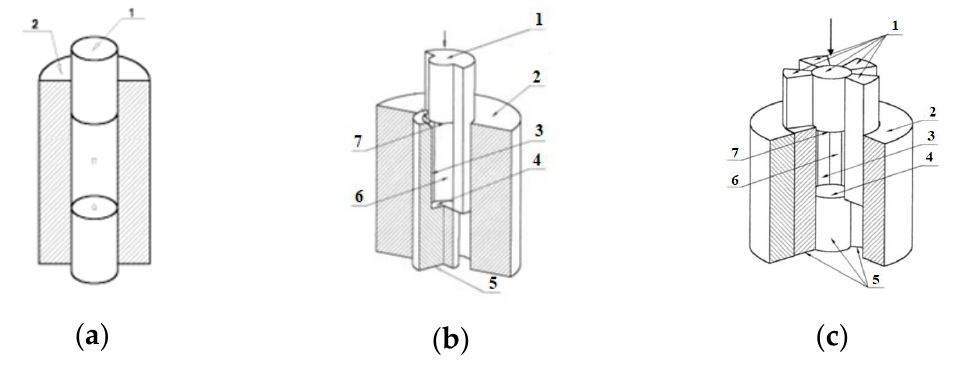
Figure 1. Cylindrical molds for dry pressing: ( a )—standard mold (1—punch, 2—matrix); ( b , c )—collector molds: 1, 5—independent punches; 2—matrix; 3 and 6—side punch surfaces; 4 and 7—pressing punch surfaces.